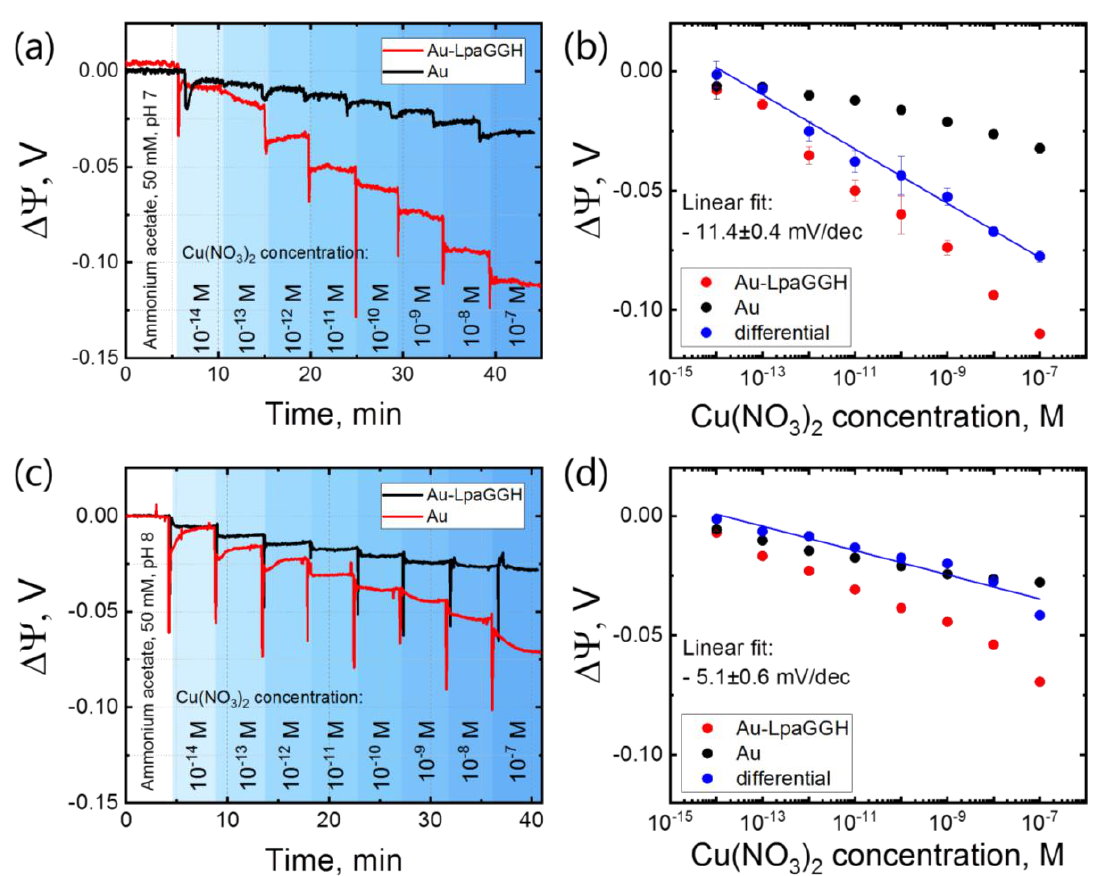
Figure 2. Response of the GGH ligand to Cu(NO 3 ) 2 in the concentration range of 10 fM to 0.1 µM. Real-time measurements of the surface potential shift ∆Ψ for increasing concentrations of Cu(NO 3 ) 2 in ammonium acetate (50 mM), pH 7 ( a ) and pH 8 ( c ). For drift correction, a baseline is subtracted from the measured data and the measured curves are shifted to zero (see Methods). ( b , d ) Differential response at pH 7 and 8, respectively (see Methods). The reported surface potential values are extracted from “steps” after 1 min settling time, and buffer baseline is shifted to zero.